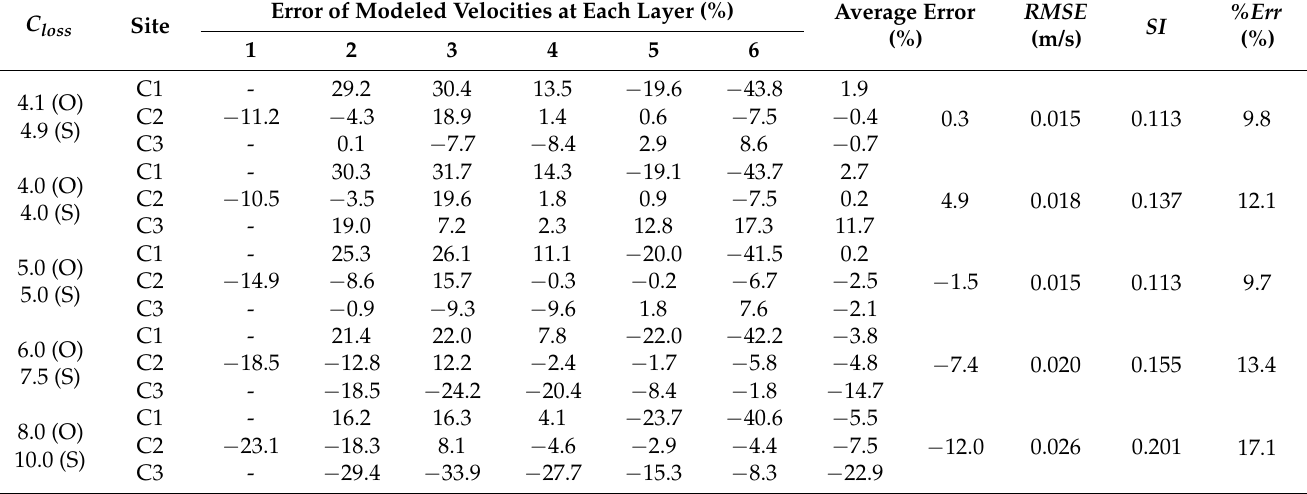
Table A1. Statistical indicators in simulation errors for different numerical experiments, approach- ing to determine the energy-loss coefficients and ( C loss − u and C loss − v ). O: oyster; S: scallop. Error = ( p - m )/ m